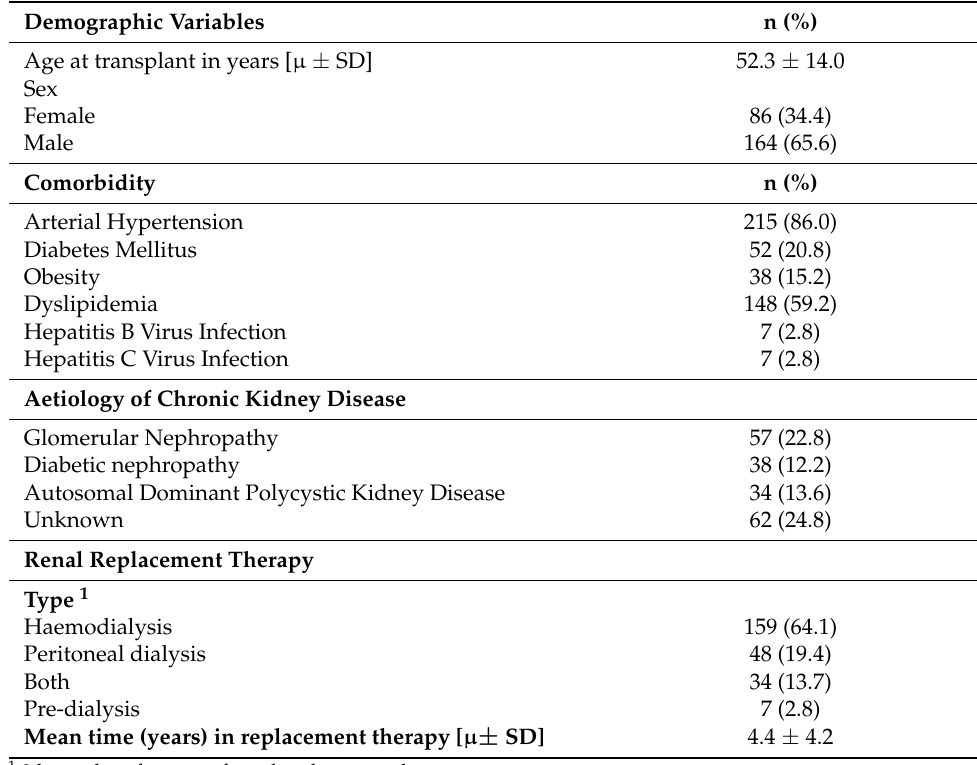
Table 1. Descriptive analysis ofthe main characteristics of the study population, including demo- graphical, comorbidity, aetiology and renal replacement therapy.